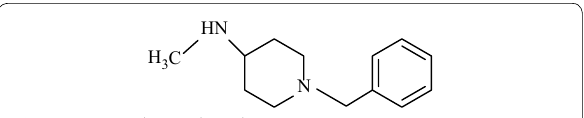
Fig. 6 Acetamide pendent derivative C3